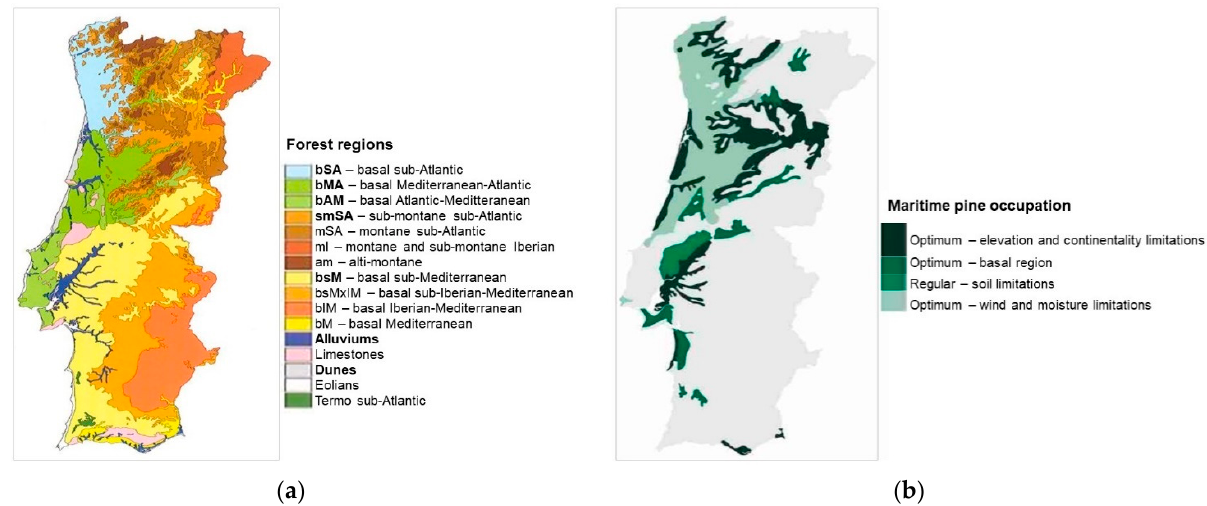
Figure 2. Maritime pine empirical distribution: ( a ) forest regions in Portugal [52]; and ( b ) Maritime pine occupation by Oliveira [17]. Forest regions of Maritime pine occurrence (in bold). bSA—basal Sub-Atlantic; bMA—basal Mediterranean– Atlantic; bAM—basal Atlantic–Mediterranean; bsM—basal sub-Mediterranean; and smSA—sub-montane sub-Atlantic.